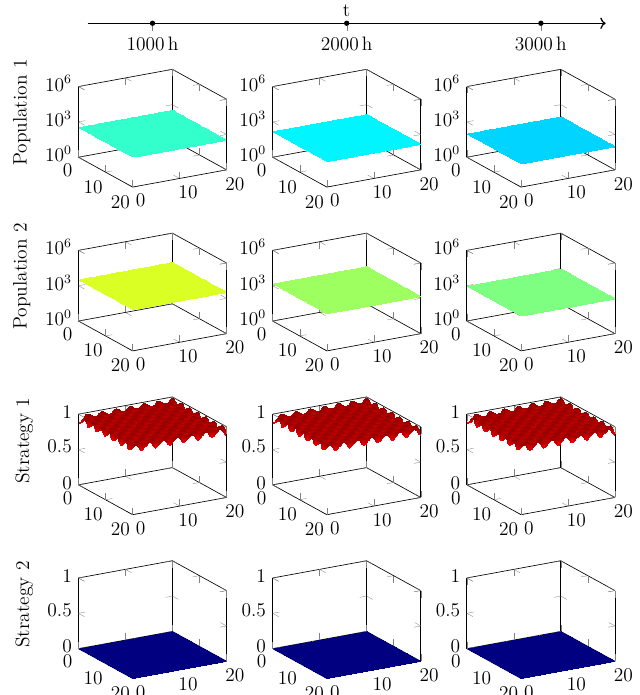
Figure A1. Long-term behaviour of two populations with different start strategies, using a G -function without additions.